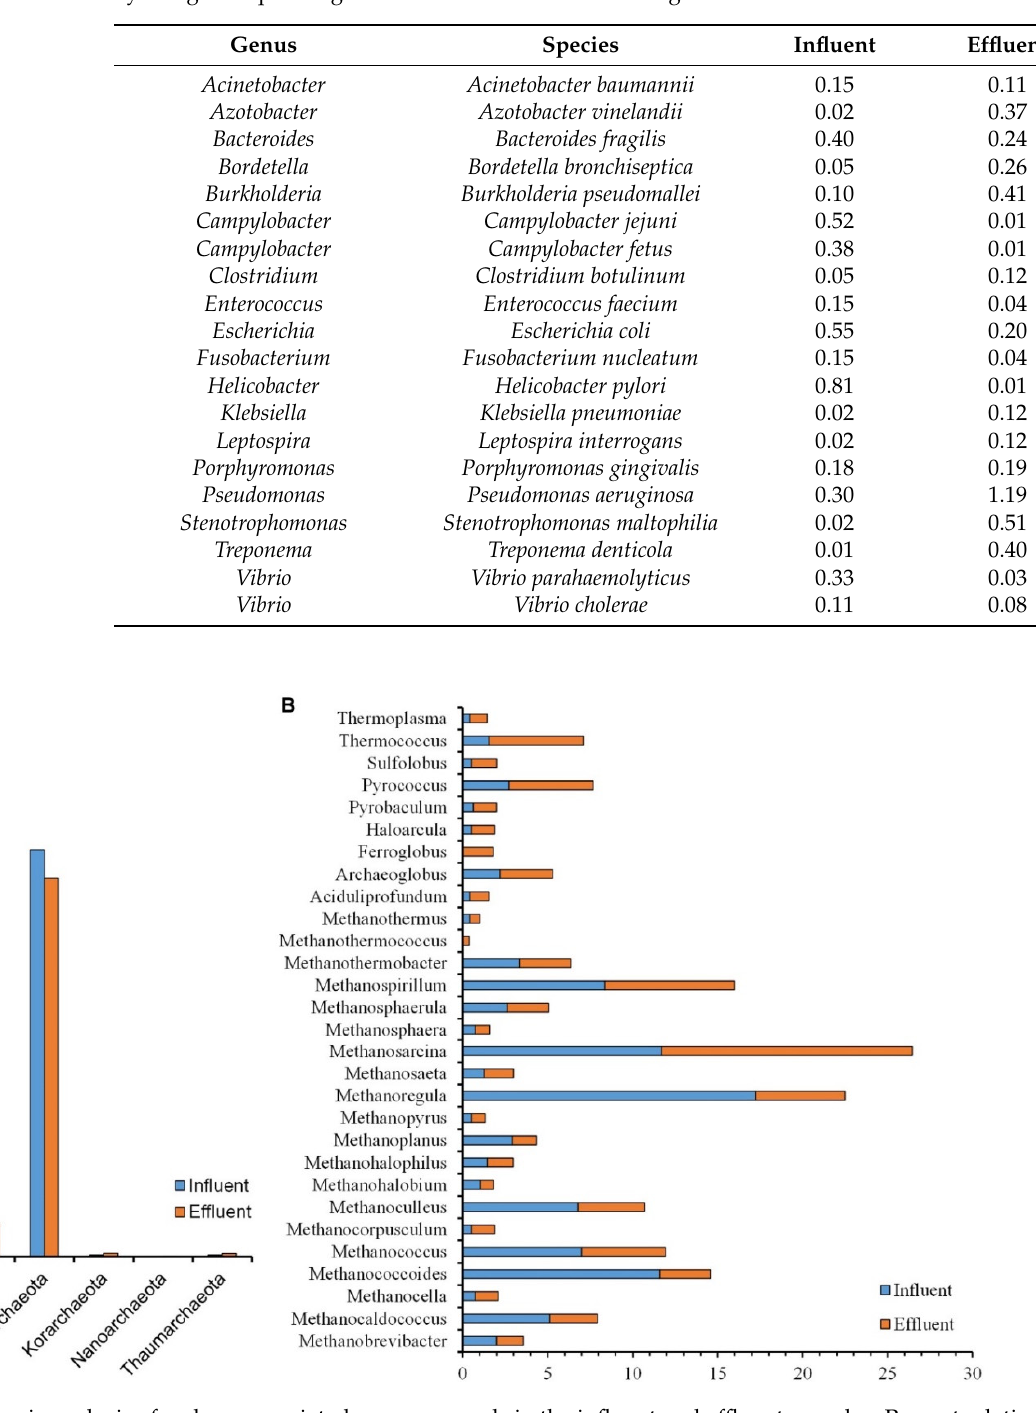
Table 1. Percentage relative abundance of potential pathogens at genus and species levels revealed